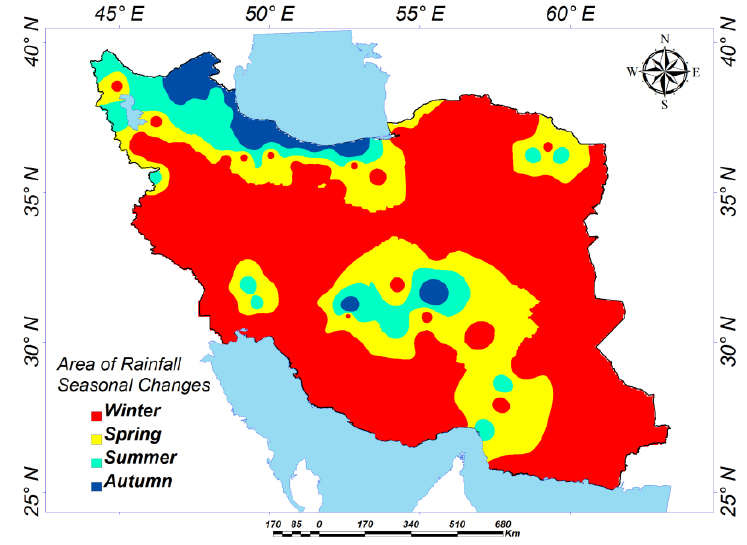
Figure 17. Area of rainfall seasonal variations (additive).